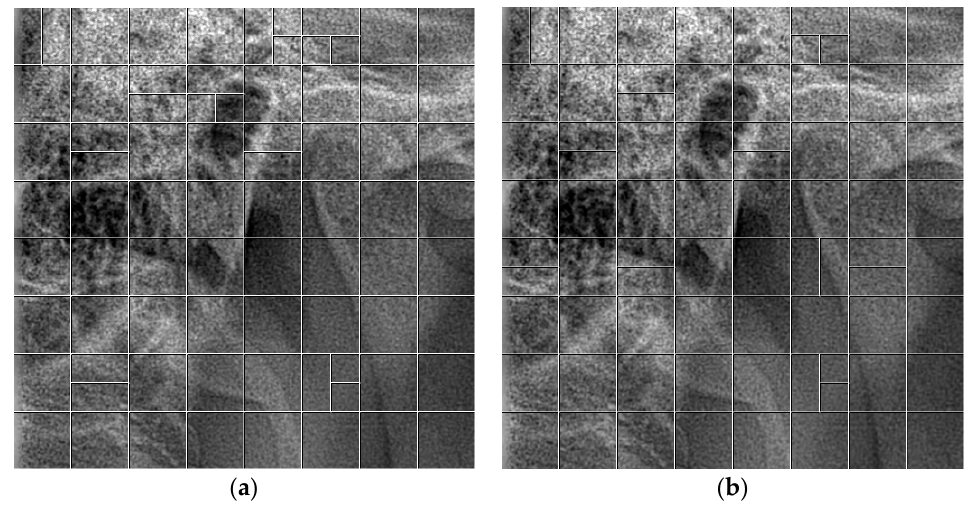
Figure 2. The 512 × 512 pixel fragment with two partition schemes obtained for quantization step (QS) = 3 ( a ) and QS = 13 ( b ).